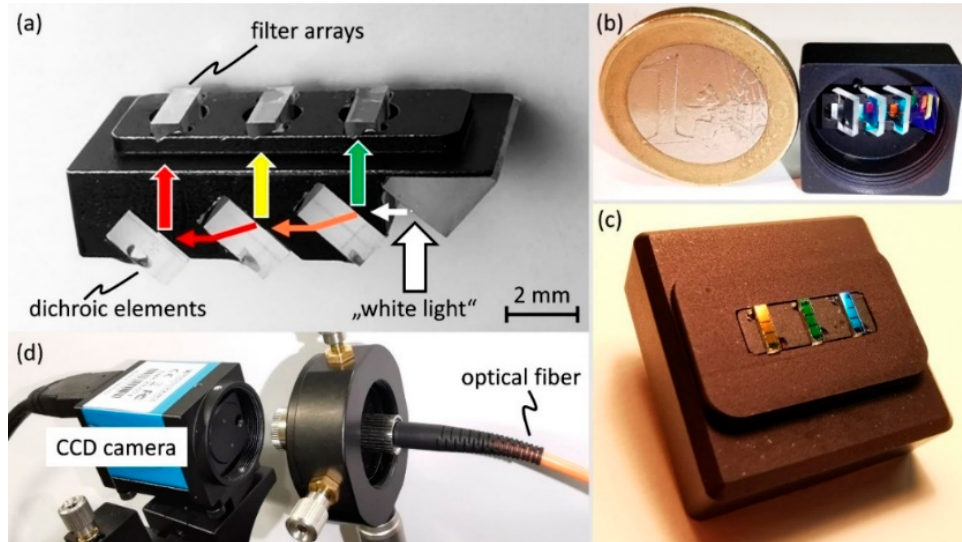
Figure 9. Efficiency increased module comprising dichroic beam splitters and FP filter arrays. ( a ) Photo of the preselection module with schematic beam path. ( b , c ) Photos of the module integrated in a housing. ( b ) Front side of the module displayed together with a coin (1EUR ) for size comparison. ( c ) Back side of the module, where the three glass substrates carrying FP filter arrays are visible. ( d ) Measurement setup: closed module connected to a CCD camera is illuminated by an optical fiber.